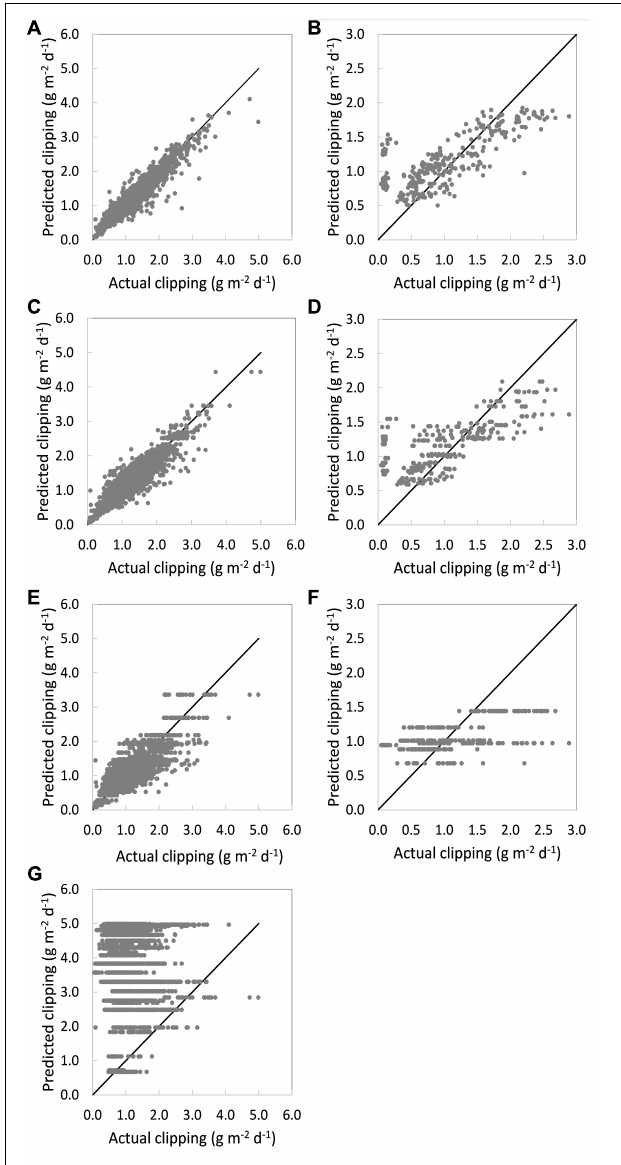
FIGURE 2 | Scatter plot of the model performances with (A) complete random forest (RF) model with all variables inputs on the training dataset; (B) complete RF model with all variables inputs on the validation dataset; (C) simplified RF model with the historical nitrogen (N) rate record, traffic intensity, and weather data on the training dataset; (D) simplified RF model with the historical N rate record, traffic intensity, and weather data on the validation dataset; (E) simplified RF model with only weather data input on the training dataset; (F) simplified RF model with only the weather data input on the validation dataset; (G) PACE Turf GP